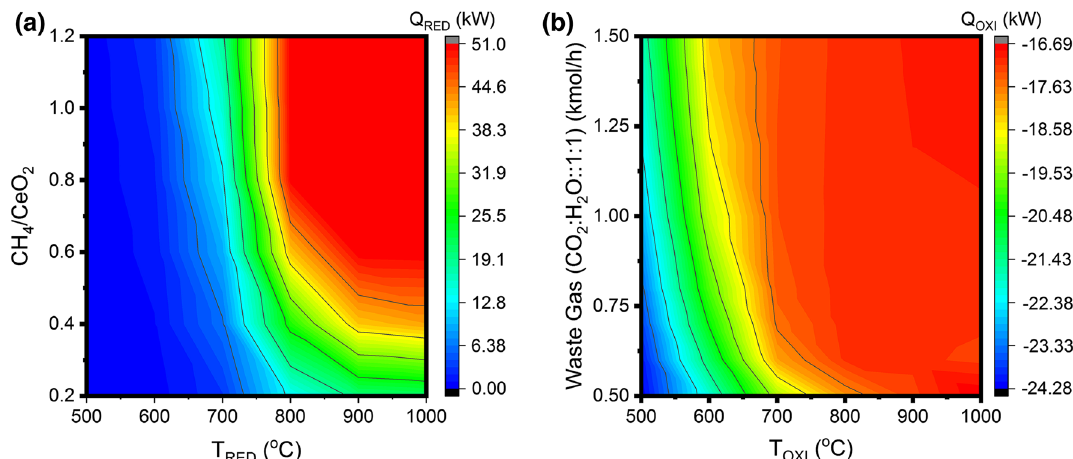
Fig. 8 Heat need/release from the reduction and oxidation reactions as per: a with a variation of CH reduction reactor; b with a variation of the waste gas flow at an equimolar mixture composition and temperature in the oxidation